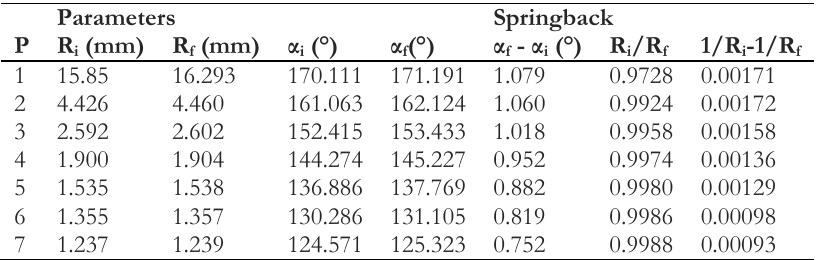
Table 3. Springback of a 2 mm sheet.